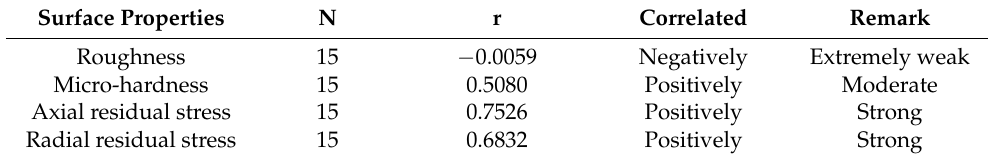
Table 10. The results of Pearson correlation